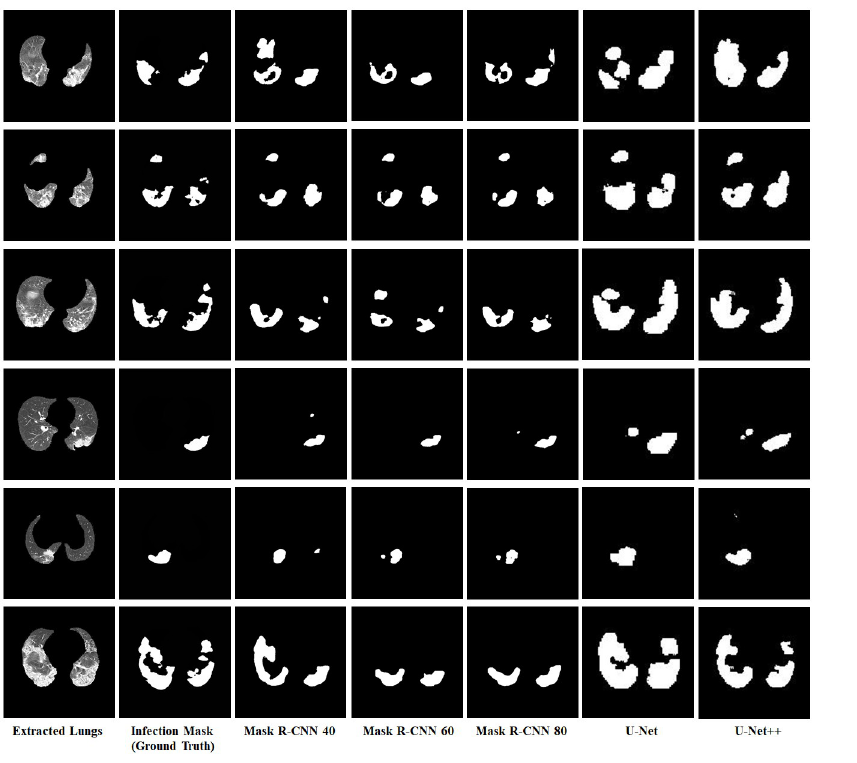
Fig 12. Sample segmentation outputs for all